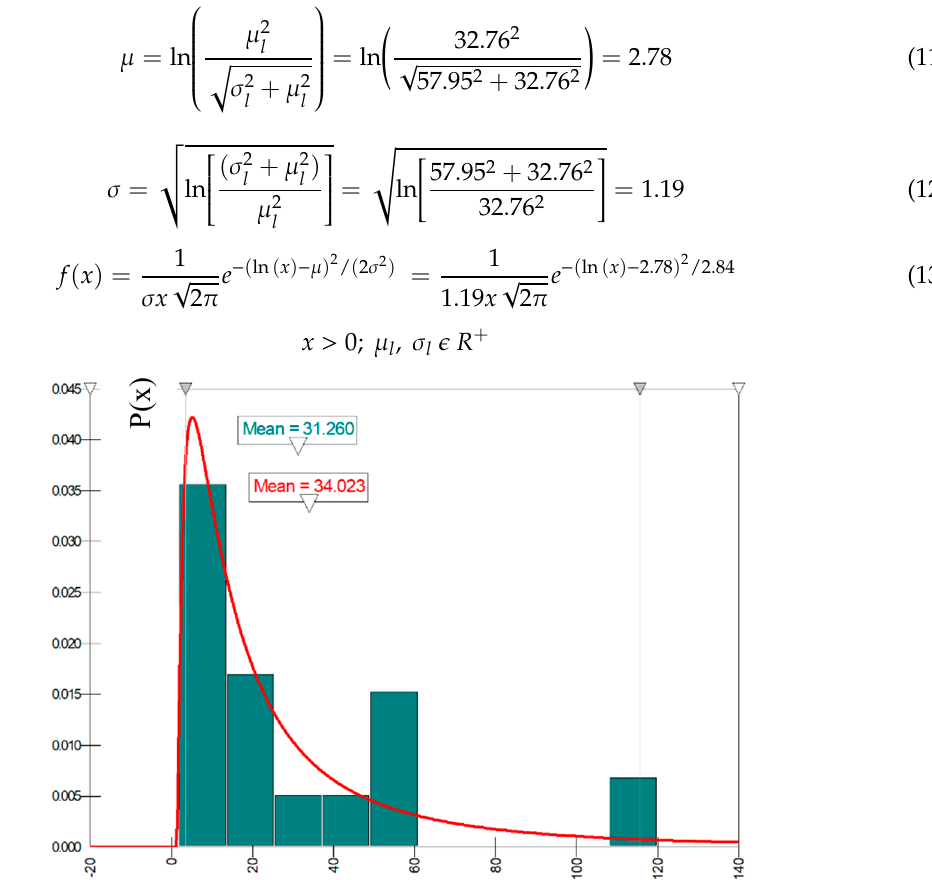
Figure 6. Time between two handheld UHF radio routine calls [min].